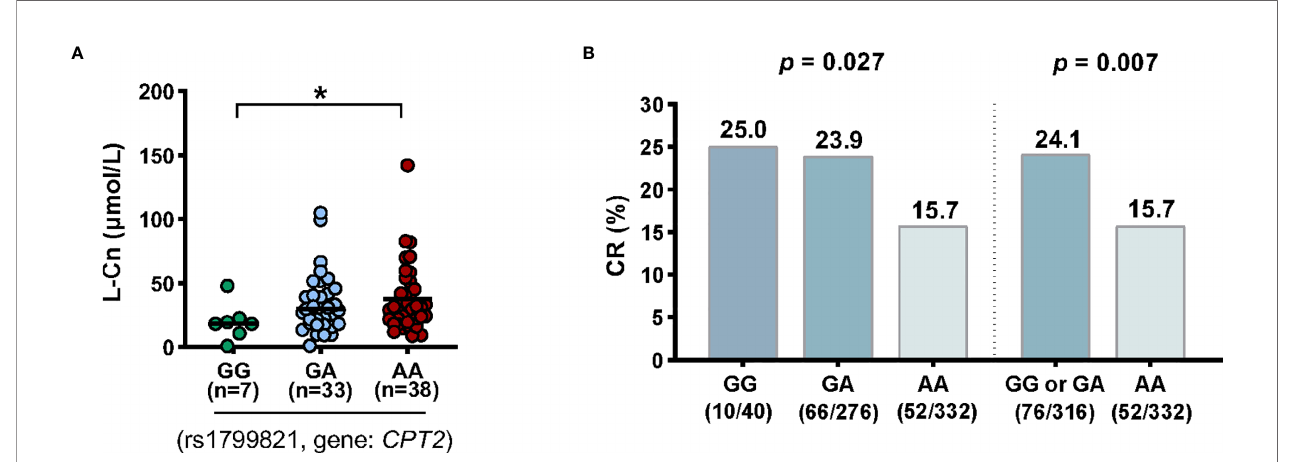
FIGURE 5 | Association of CPT2 rs1799821 with plasma L-Cn levels and CR in patients treated with Peg-IFN a . (A) Association of plasma L-Cn levels with SNP rs1799821 genotype. (B) Association of SNP rs1799821 genotype with CR in patients treated with Peg-IFN a . (A) Kruskal-Wallis H test and Dunn ’ s multiple